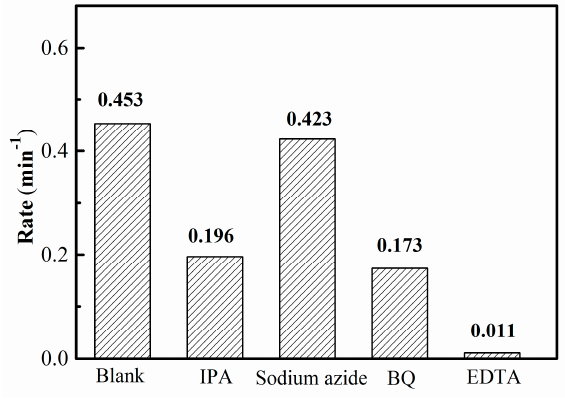
Figure 11. The effects of different scavengers for the DCF photodegradation with Ag 3 PO 4 /g ‐ C 3 N 4 (30%) under visible ‐ light irradiation.